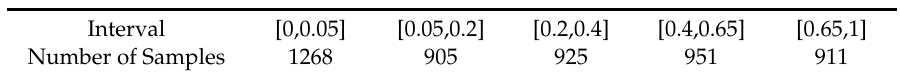
Table 4. Statistics of samples in each interval.